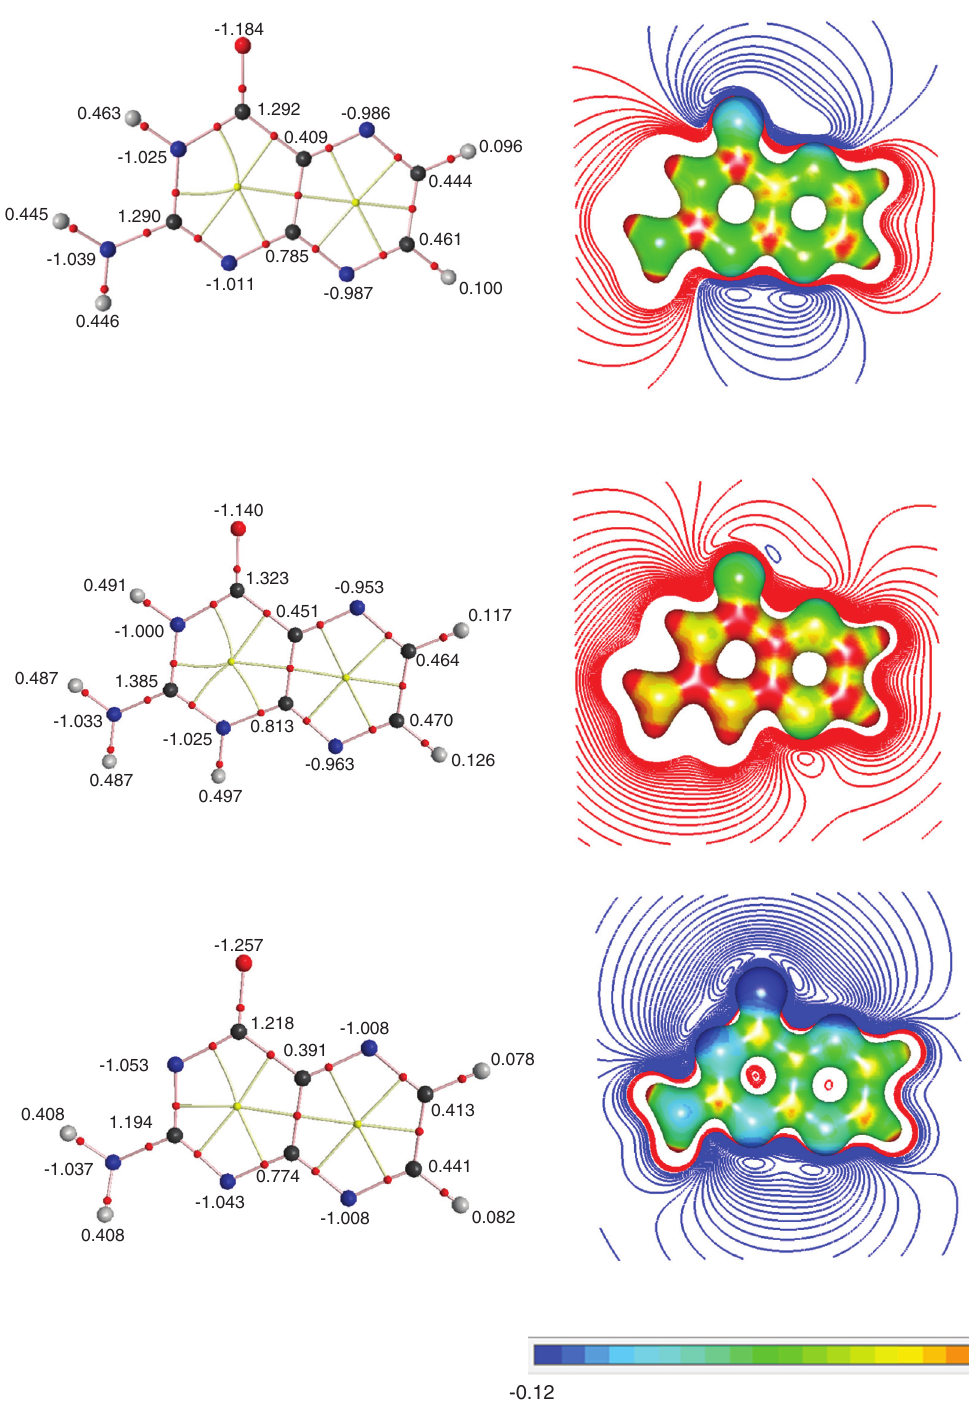
Figure 3 QT-AIM atomic partial charges (left column) and visualizations of the electron density functions and the ESP of neutral (top), cationic (middle) and anionic (bottom) pterin (right column). The molecules are represented by the isodensity surfaces at 0.10 a.u. of elec- tron density function, coloured according to the local ESP (for color code see bottom of the Figure). Blue ESP contours: negative ESP from –0.01 a.u. (outermost contour) in steps decreasing in –0.01 a.u. steps. Red ESP contours: positive ESP from +0.01 a.u. (outermost contour) increasing in +0.01 a.u. steps. For these plots, electron density functions and ESP functions are evaluated by program G09W using regular 192 × 192 × 192 cubes surrounding the molecular